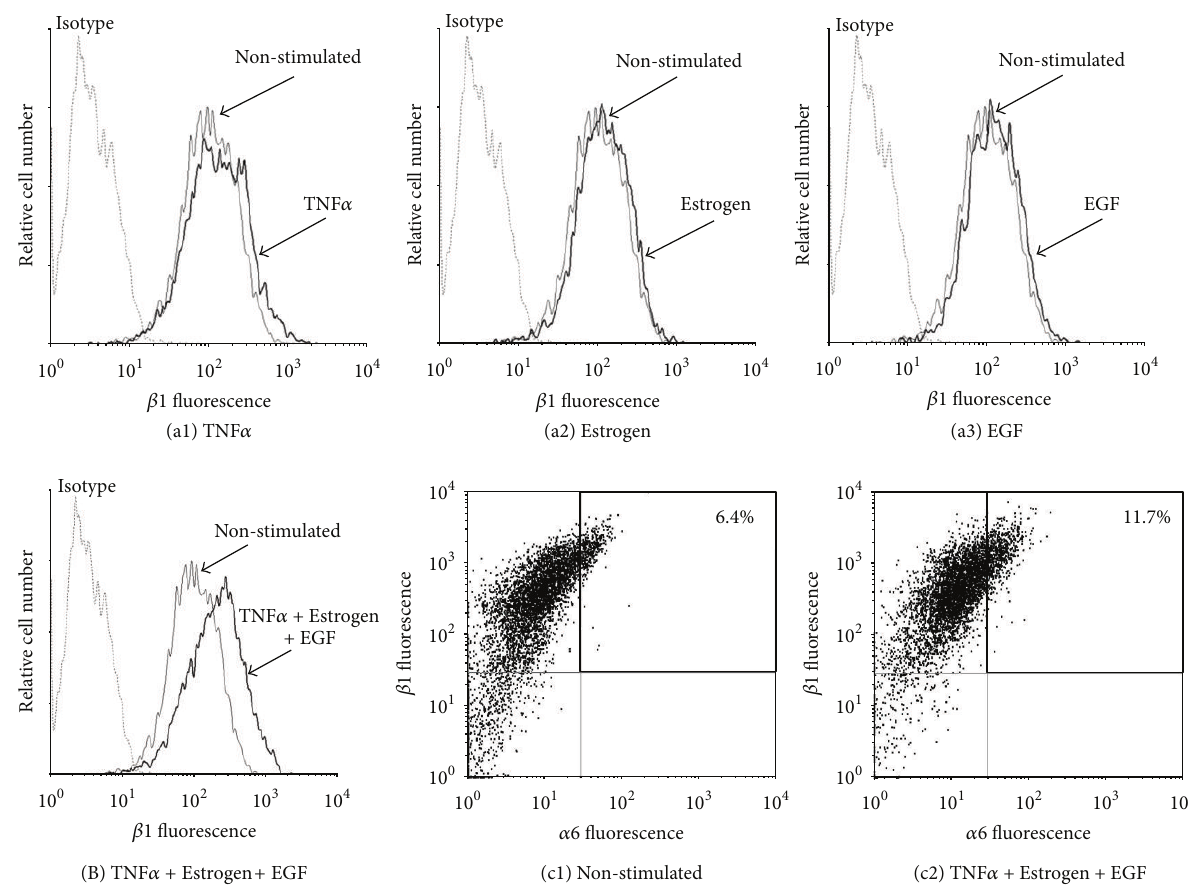
Figure 4: Combined stimulation of breast tumor cells by TNF 𝛼 + Estrogen + EGF leads to increased expression of the 𝛽 1 integrin and to emergence of high-VLA6 cell population ( 𝛼 6 𝛽 1 high ). ((a), (B)) Determination of 𝛽 1 expression. Breast tumor cells were stimulated by (a1) TNF 𝛼 , (a2) estrogen, (a3) EGF, or (B) TNF 𝛼 + Estrogen + EGF (concentrations as in Figure 1) for three days. Non-stimulated: cells grown with the diluents of the above factors. The expression of 𝛽 1 on the surface of the cells was determined by FACS analyses, using specific Abs. Isotype: isotype matched Abs used as control in the FACS analyses. In all panels, the results are from a representative experiment of 𝑛 ≥ 3 . (c) Coexpression of the 𝛽 1 and 𝛼 6 integrin subunits. (c1) Non-stimulated: cells grown with the diluents of the above factors. (c2) Cells stimulated by TNF 𝛼 + Estrogen + EGF (concentrations as in Figure 1). The expression of 𝛽 1 and of 𝛼 6 on the surface of the cells was determined by FACS analyses using specific Abs, with axes set based on staining with isotype matched control Abs. In all panels, the results are from a representative experiment of 𝑛 ≥ 3